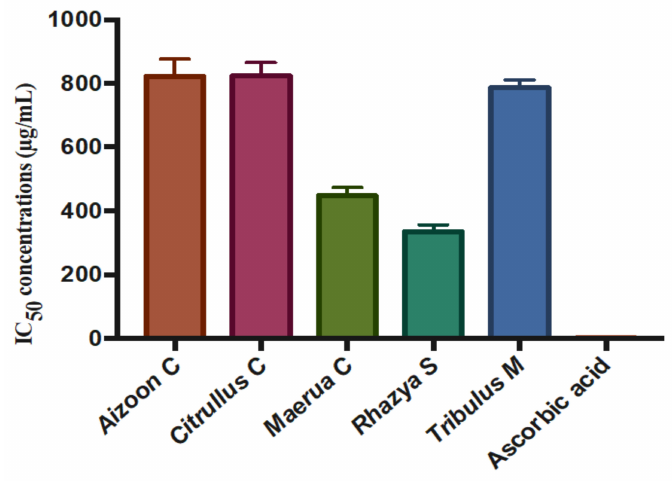
Figure 5. Comparison of the 50% DPPH scavenging activities of the different plant extracts (mean ± S.D.). The results were obtained through three independent